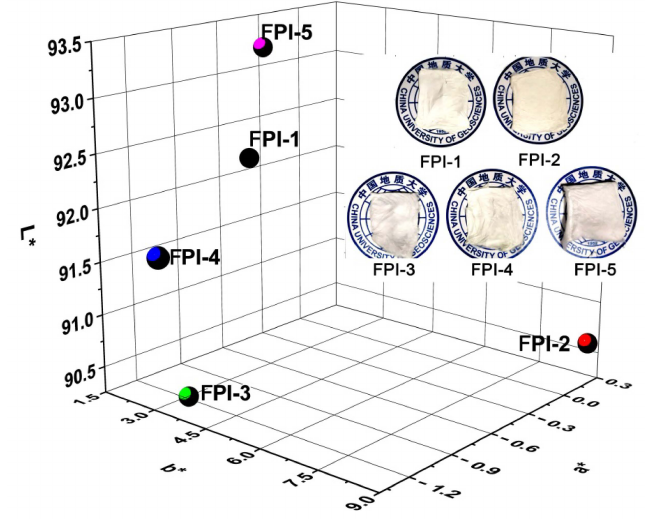
Figure 7. 3D CIE Lab color parameters of FPI UFMs (Insert: Appearance of FPI